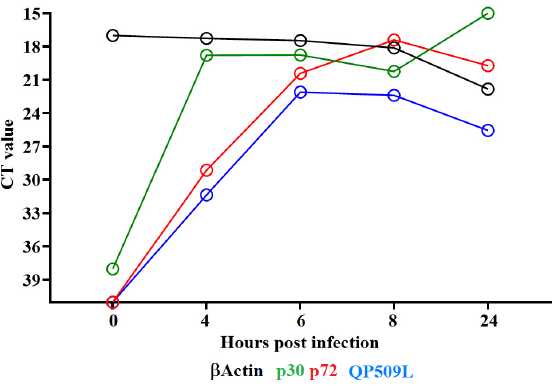
Figure 3. Expression profile of the QP509L gene of ASFV during in vitro infection of porcine macrophages. Reverse transcription followed by qPCR was used to evaluate the expression profile of the QP509L gene during in vitro infection at different time points, up to 24 h. As a reference for this analysis, we used qPCRs to specifically detect the expression of genes encoding ASFV proteins, p30 (early expression) and p72 (late expression). Additionally, the β -Actin gene was used as a control to evaluate the quality and levels of RNA during the infection at different time